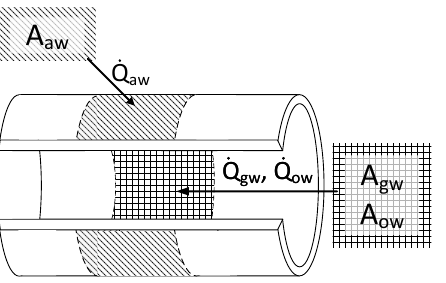
Figure 4. Wall element with surface areas and heat flow